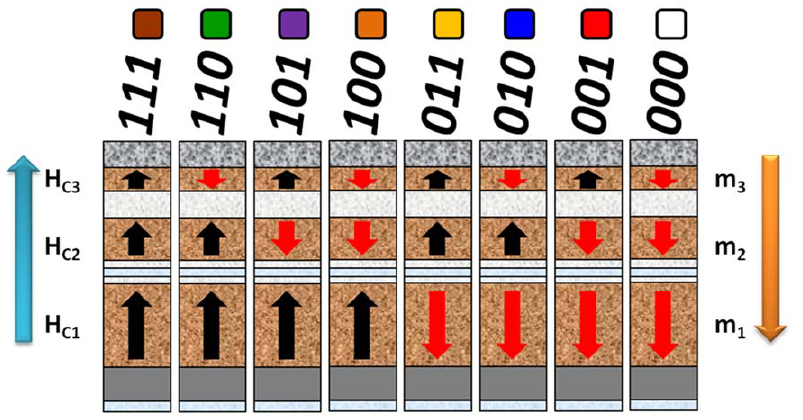
Figure 1. Triple-stack ML-3D BPM. Schematic of the structure and desired magnetic properties (not to scale). The black arrows (binary ‘‘1 0 ) and red arrows (binary ‘‘0 0 ) denote the two possible magnetic states in each stack. Above the columns lies the binary representation and color coding for the eight possible magnetic states.